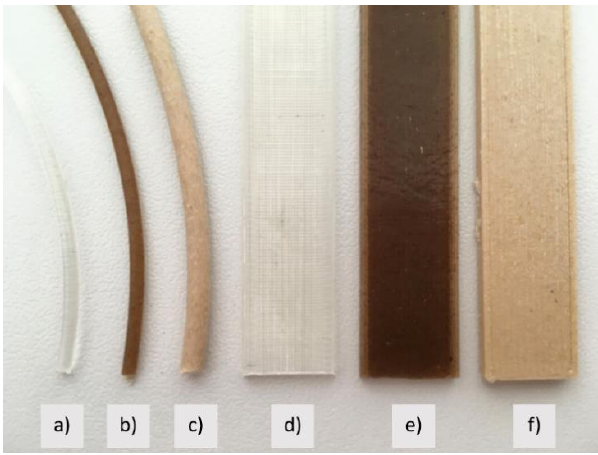
Figure 7. Samples of filaments: ( a ) PLA_f, ( b ) PLA-Entwined_f, ( c ) PLA-Woodfill_f, and 3D prints: ( d ) PLA_3D, ( e ) PLA-Entwined_3D and ( f ) PLA-Woodfill_3D. ( d ) PLA_3D, ( e ) PLA-Entwined_3D and ( f )